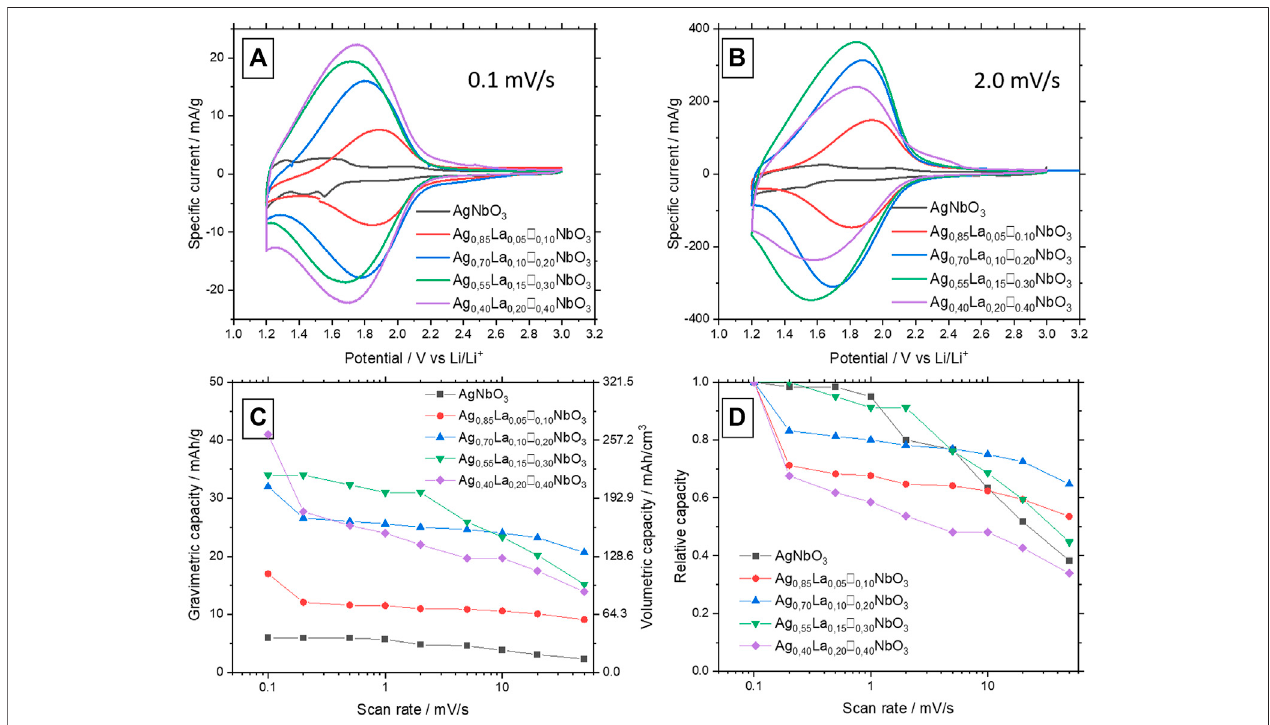
FIGURE4|(A) CVat0.1 mV s − 1 between1.2and3 VofAg 1-3x La x □ 2x NbO 3 fordifferentvalueofx. (B) CVat2.0 mV s − 1 between1.2and3 VofAg 1-3x La x □ 2x NbO 3 fordifferentvalueofx. (C) Speci fi